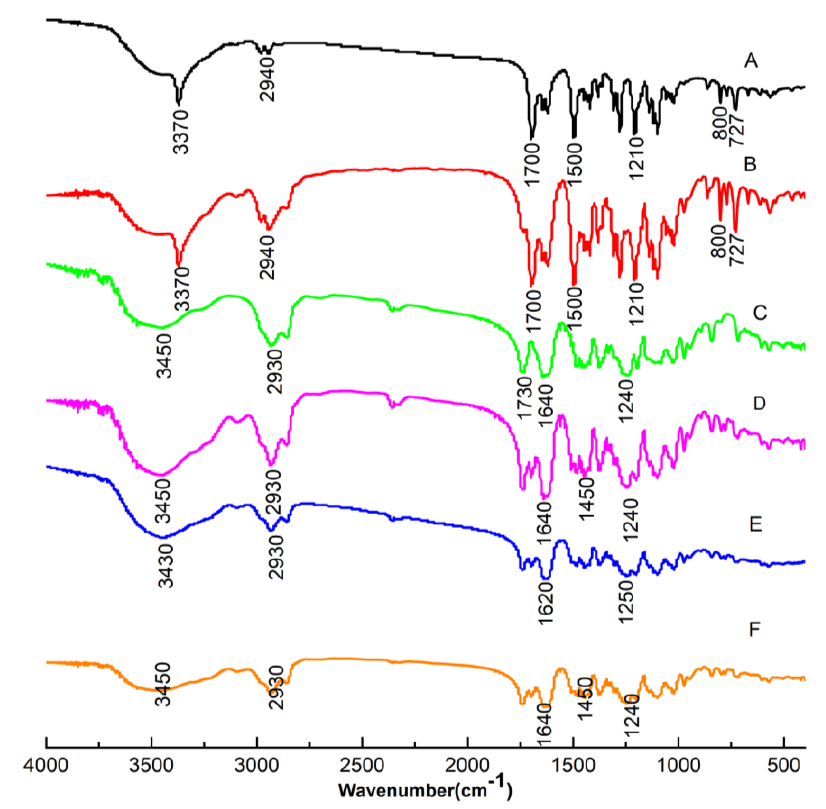
Figure 8. FT-IR spectra of samples including FEL (A), FEL PM (B), Soluplus ® (C), faSDDS SE (D), faSDDS QC (E) and faSDDS HME (F).